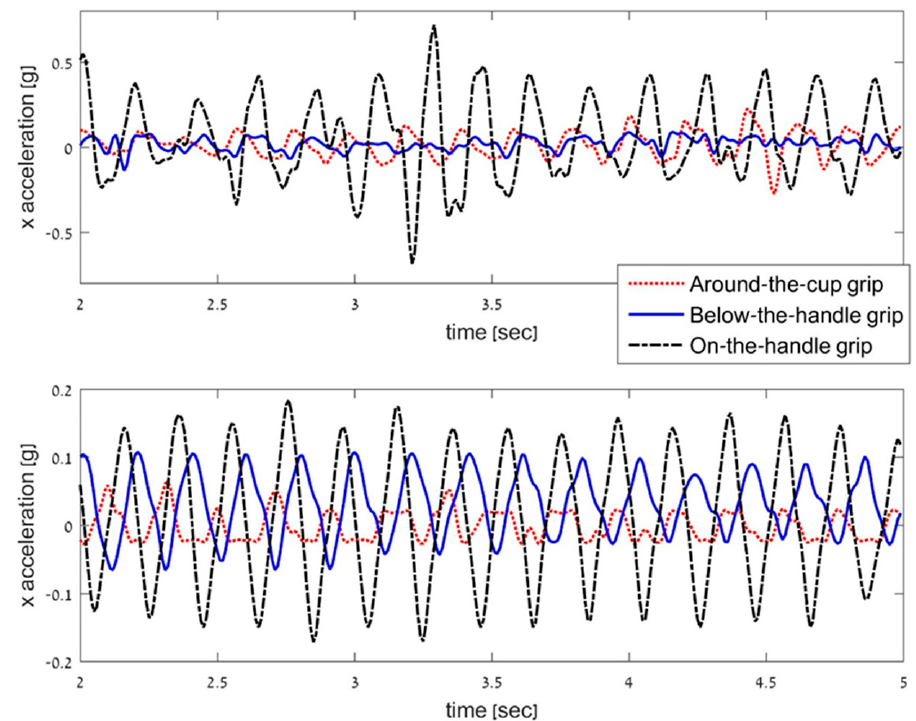
Figure 2. Example of X -Axis Acceleration for Two Participants with Essential Tremor.